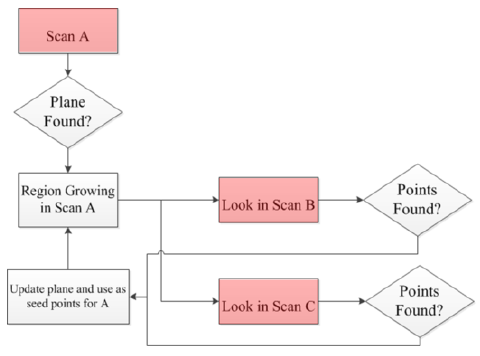
Figure 4: A flowchart demonstrating the heterogeneous segmentation Figure 5: A cross section of a cylinder-shaped structural column before (a) and after (b) running the ICPP.